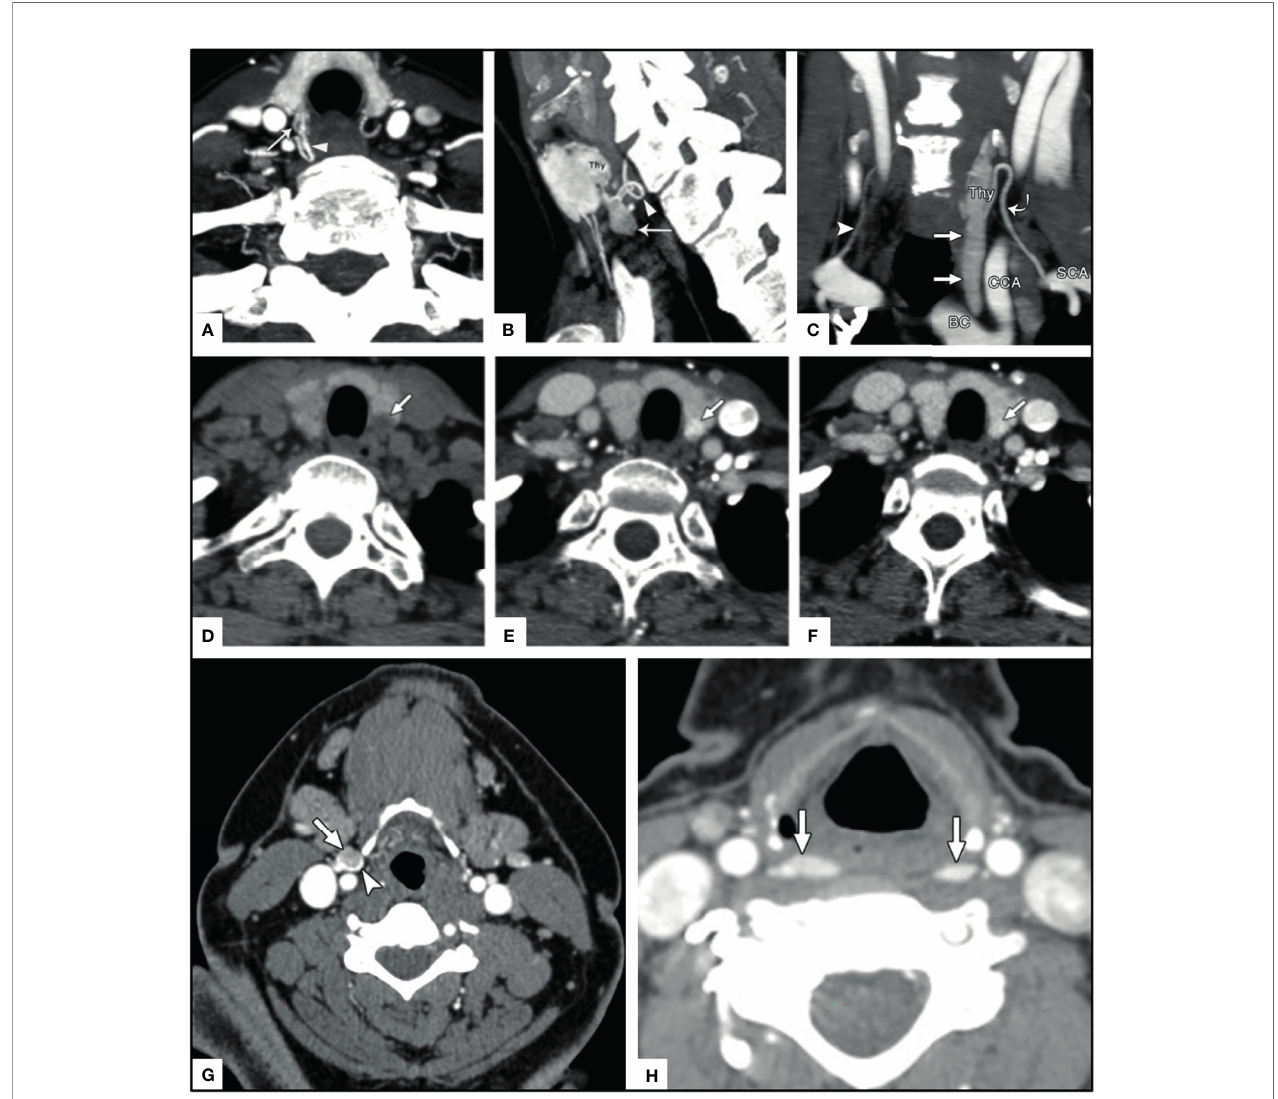
FIGURE 9 | 4DCT imaging of parathyroid adenomas. Upper panels (A) arrow head on axial image, (B) arrow head on sagittal image, and (C) curved arrow on coronal images depict the polar vessel sign in PA (straight arrows) with arterially enhancing prominent feeding vessel. Middle panels depict a thyroid nodule (arrow) mimicking a PA on (D) non-contrast axial, (E) arterial axial, and (F) venous axial imaging. Lower panels depict ectopic PA in unusual locations near the carotid sheath (arrow and arrowhead) similar to paraganglioma (G) and in the retropharyngeal region (arrows) (G) where they could easily be confused for lymphadenopathy. Reproduced with permission from: (A – C) Bahl M, Muzaffar M, Vij G, Sosa JA, Choudhury KR, Hoang JK. Prevalence of the polar vessel sign in parathyroid adenomas on the arterial phase of 4D CT. AJNR Am J Neuroradiol. 2014 Mar;35(3):578-81. doi: 10.3174/ajnr.A3715. Epub 2013 Aug 14. PMID: 23945223; PMCID: PMC7964736. (D – H) Hoang JK, Sung WK, Bahl M, Phillips CD. How to perform parathyroid 4D CT: tips and traps for technique and interpretation. Radiology. 2014 Jan;270(1):15-24. doi: 10.1148/radiol.13122661. PMID: 24354373